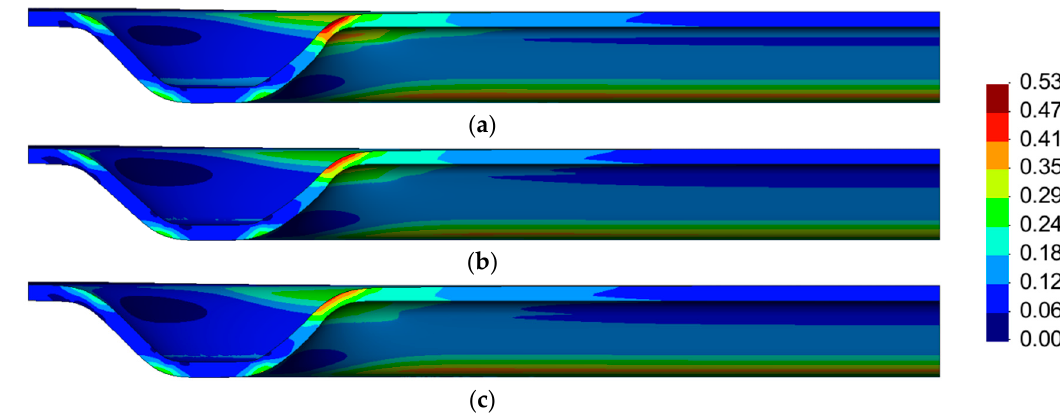
Figure 23. Equivalent plastic strain distribution plotted on the deformed configuration of the channel for different die dimensions: ( a ) s = 1.4 mm and R = 0.3 mm; ( b ) s = 1.4 mm and R = 0.4 mm; ( c ) s = 1.6 mm and R = 0.5 mm. The other parameters are w 1 = 1.2 mm, r = 0.3 mm, and h = 0.7 mm.